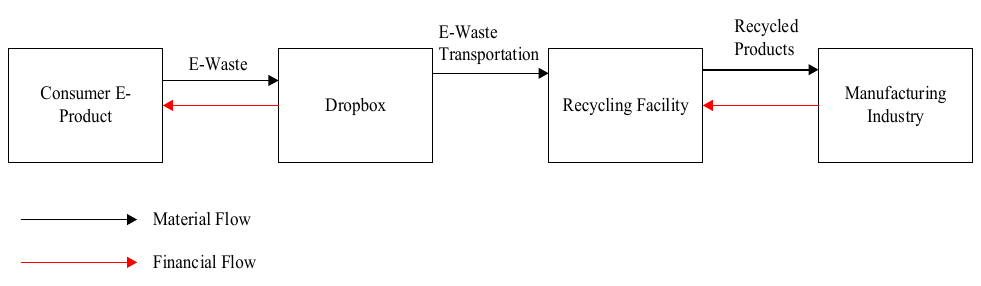
Fig. 5. Material Flow and Financial Flow without EPR.